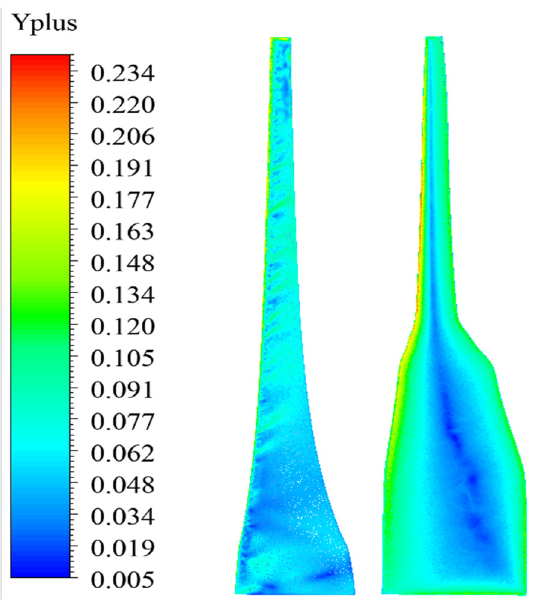
Figure 14. The y + distribution contours on the suction sides of the blades.